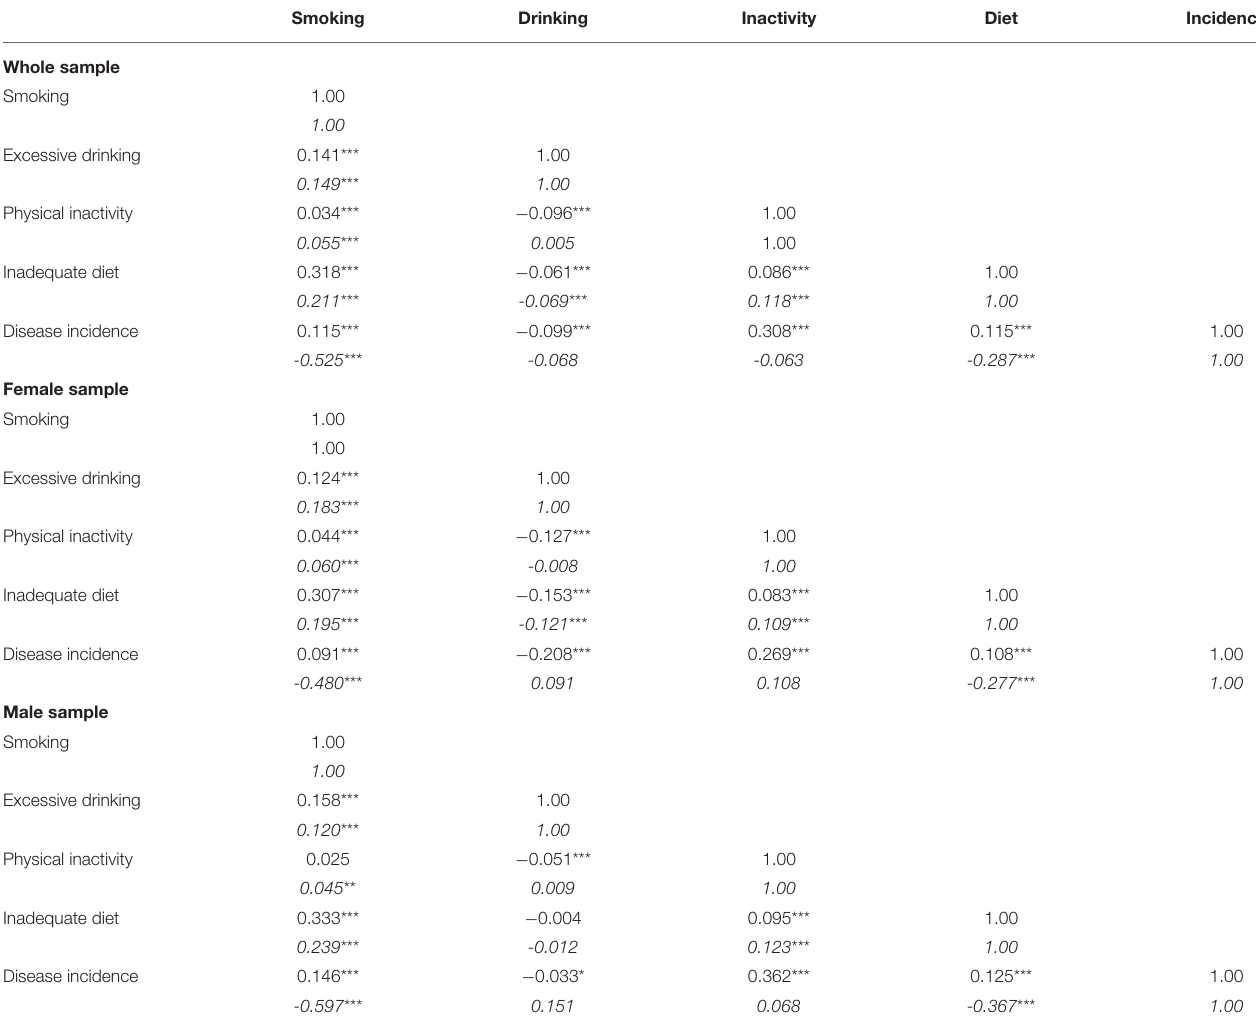
TABLE 5 | Correlation matrices for the restricted and the full model a . Smoking Drinking Inactivity Diet